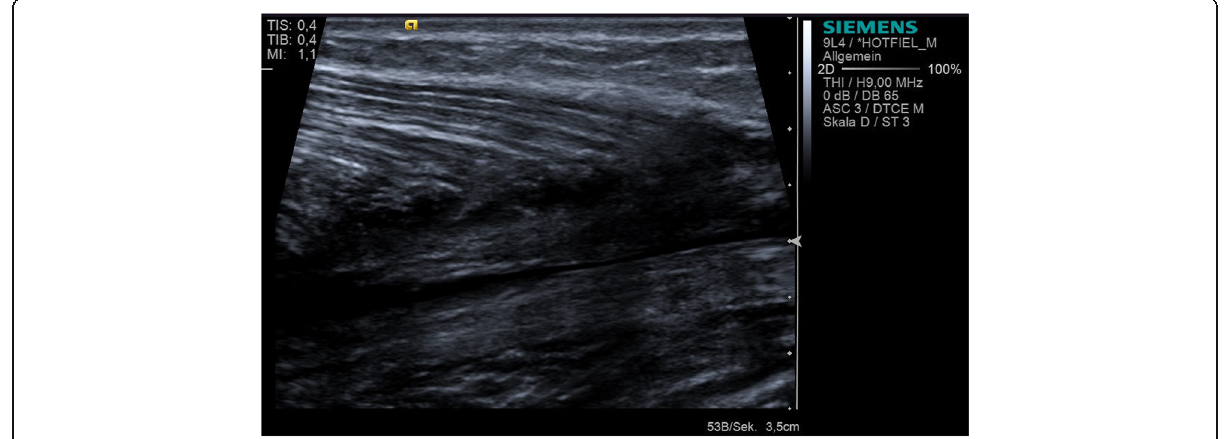
Fig. 4 Longitudinal ultrasound scan of a dorsal calf demonstrating a clearly detectable haematoma (12 h after injury) at the medial gastrocnemius